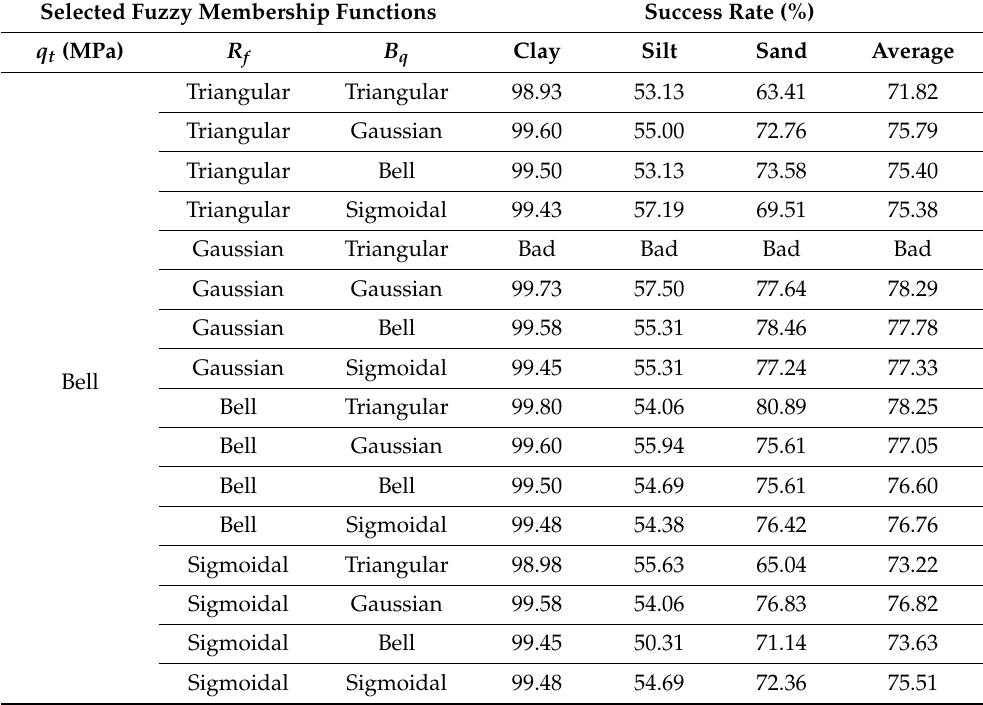
Table 6. Success rate when using a bell-shaped membership function for q t .